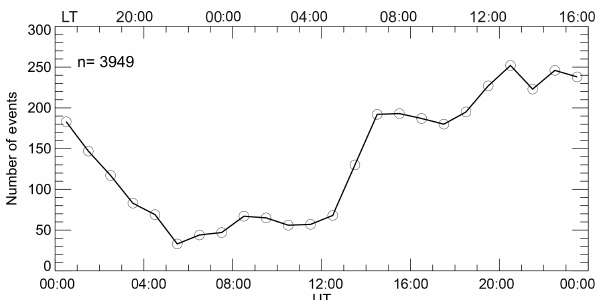
Figure 2. Number of CLY–RISR 5min intervals of joint observa- tions for all data considered. Total number of available intervals is shown in the top-left corner. For the area of observations, local time (scale at the top) roughly coincides with the magnetic local